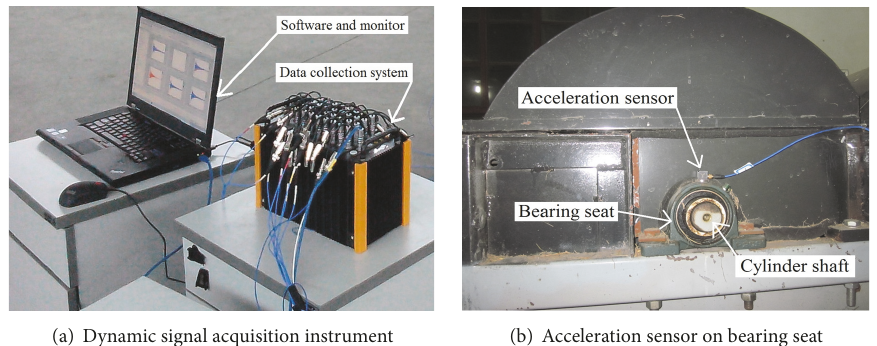
Figure 6: Bearing seat vibration test of tangential threshing